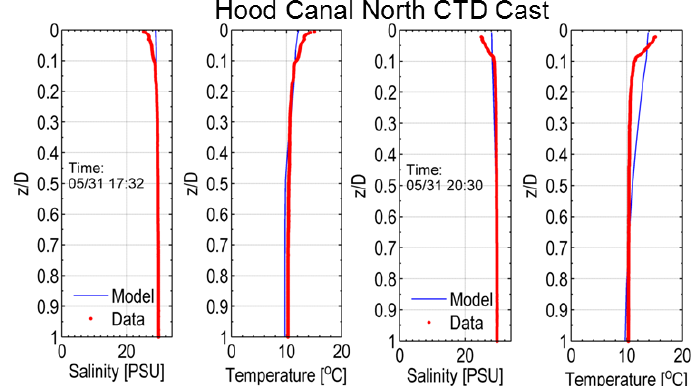
Figure 8. Comparisons of predicted and observed salinities at peak ebb and peak flood north of HCB on 31 May 2017.